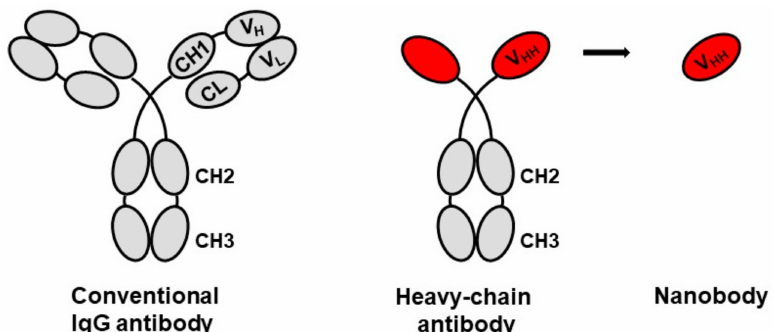
Figure 1. Schematic of conventional immunoglobulin (IgG) antibody and camelid heavy-chain only antibody with derivation of a nanobody representing the N-terminal variable antigen recognition